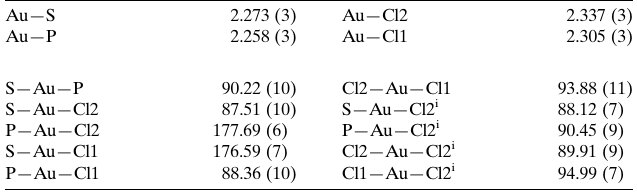
Selected geometric parameters (A˚ , (cid:3)